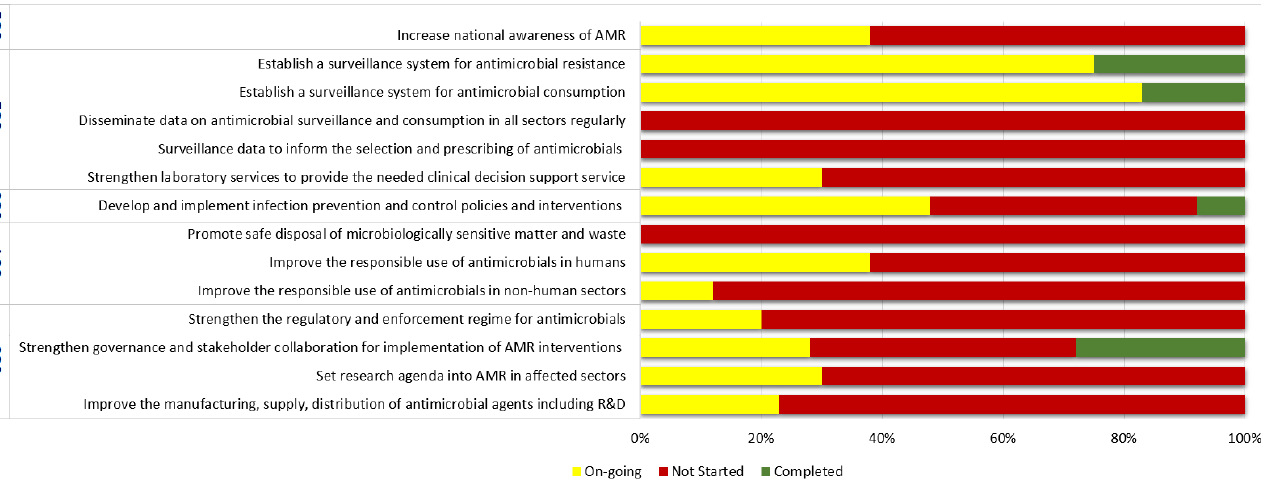
Figure 3. The review recommends the commissioning of an independent external reviewer